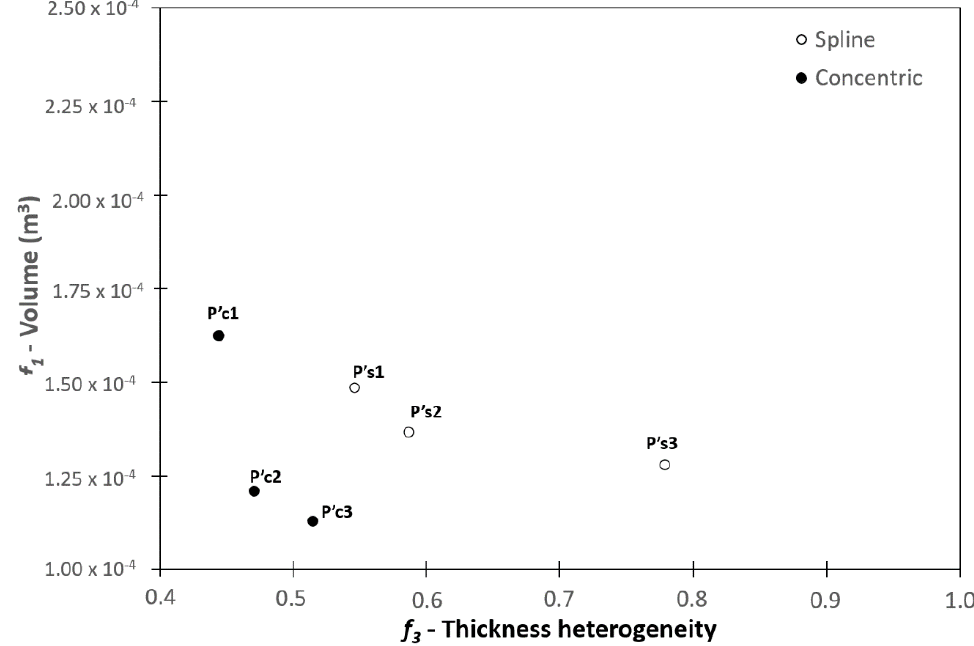
Figure 15. N on-dominated solutions of the 20th generation for Cases 4 (Spline) and 5 (Concentric), t 0 equal to 0.5